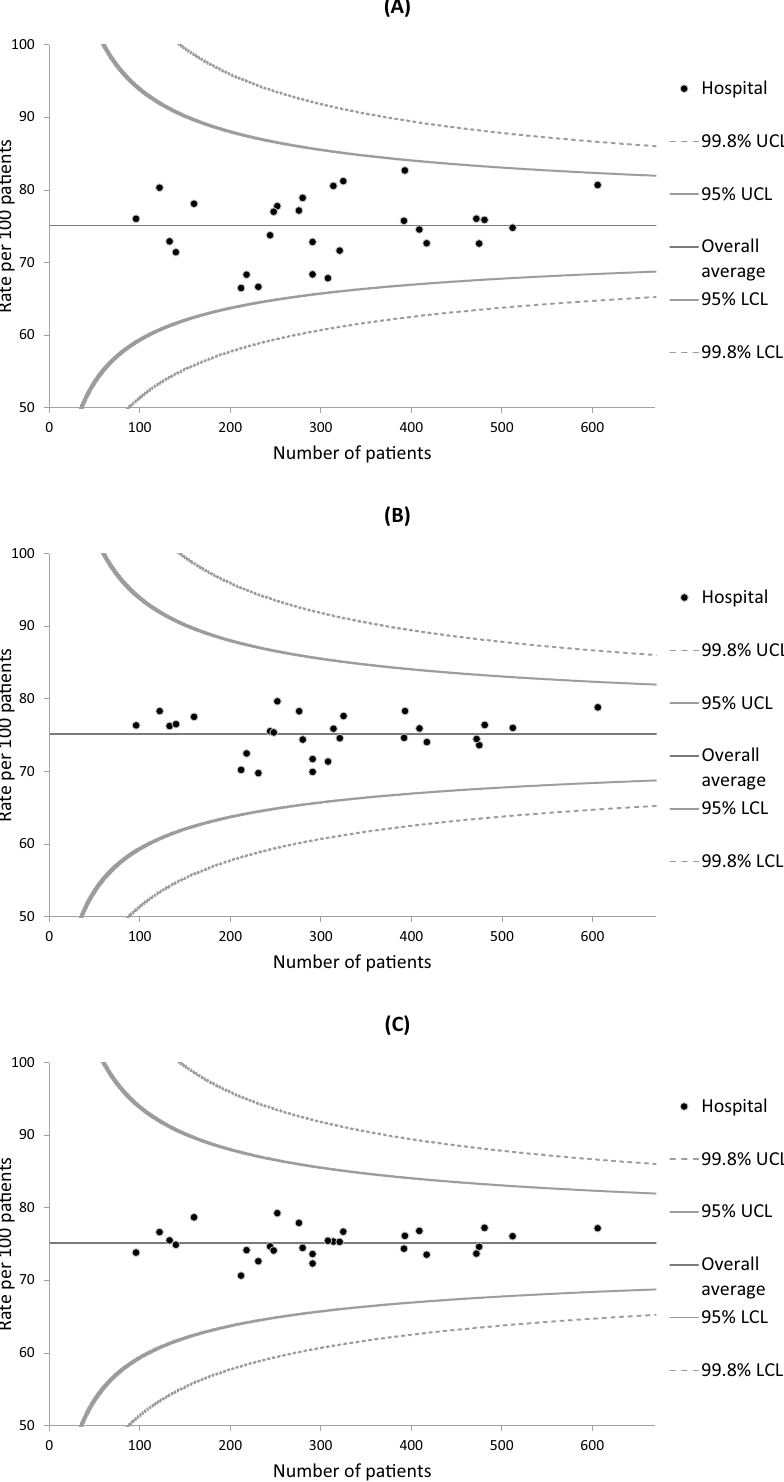
Figure 3. Funnel plots of 3-year survival and the number of colorectal cancer patients in each hospital. ( A ) Unadjusted survival; ( B ) Partially adjusted survival that controlled for age, sex, cancer stage, and tumor localization; and ( C ) Fully adjusted survival that controlled for comorbidities, activities of daily living, type of admission, smoking status, and body mass index in addition to the variables in the partially adjusted model. LCL lower control limit, UCL upper control